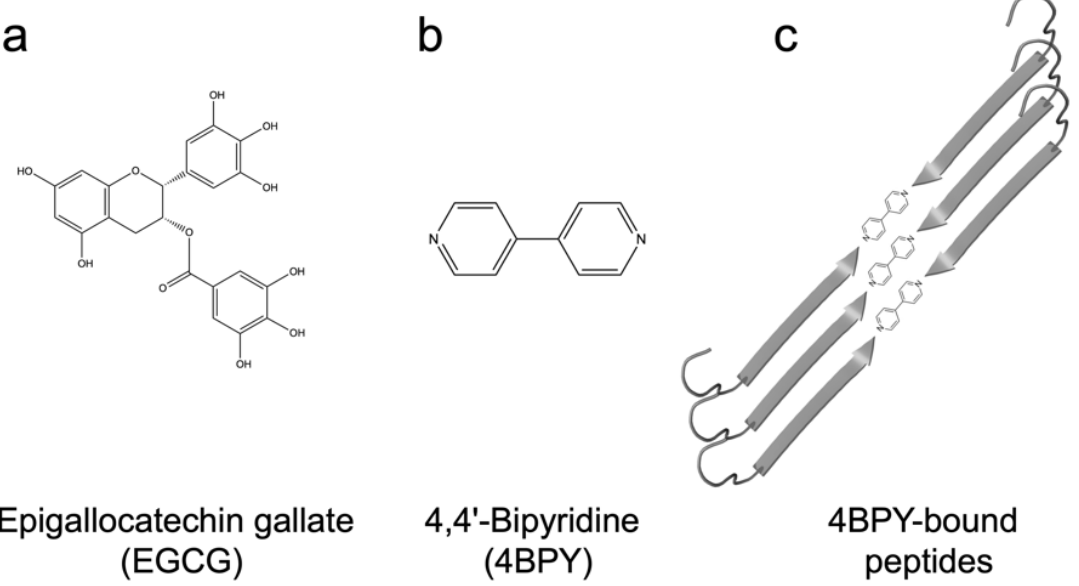
Figure 8. Molecular structures of ( a ) the polyphenol EGCG, ( b ) the chaperone-like small molecule 4BPY. ( c ) 4BPY-bound peptides seen in surface adsorbed assemblies, stabilized by hydrogen bonds between the nitrogen groups of 2BPY and peptide carboxy termini (arrow tips).